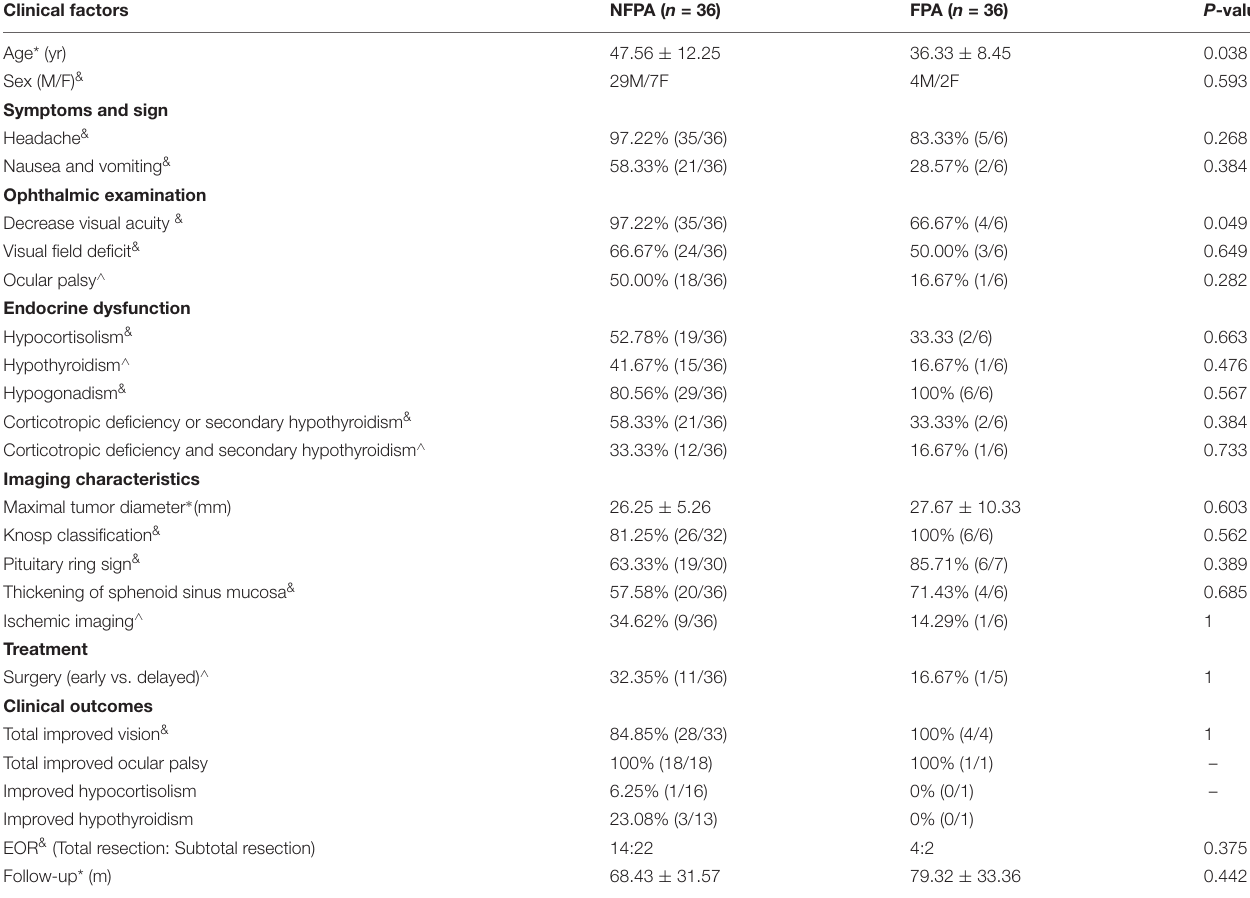
TABLE 3 | Comparison of clinical presentation and outcomes of ischemic PA between NFPA and FPA groups. Clinical